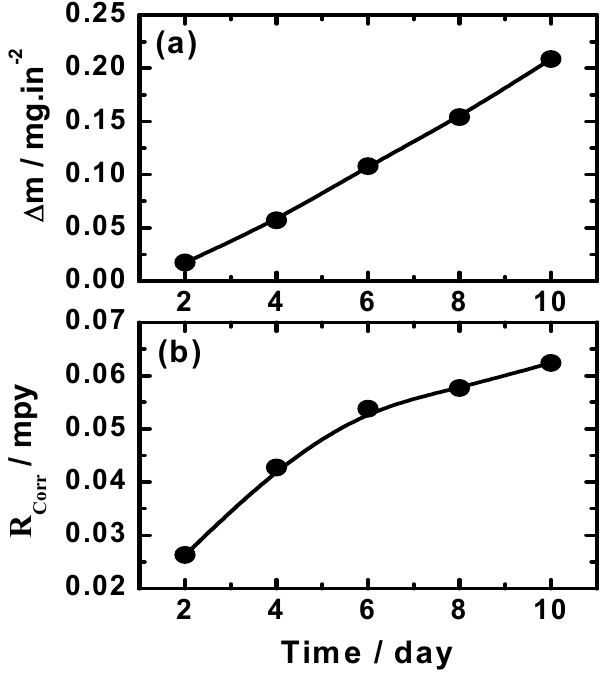
Figure 1. Change of ( a ) the dissolution rate (  m, mg/in 2 ) and ( b ) the corrosion rate ( R Corr , mpy) with time for the cast iron coupons in the Arabian Gulf seawater (AGS)